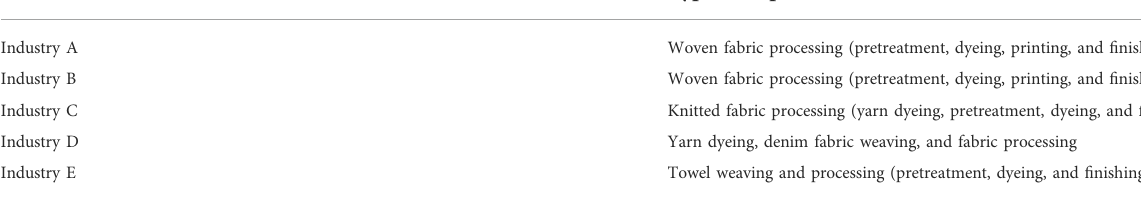
TABLE 1 Participating industries and the nature of their operations. Name of